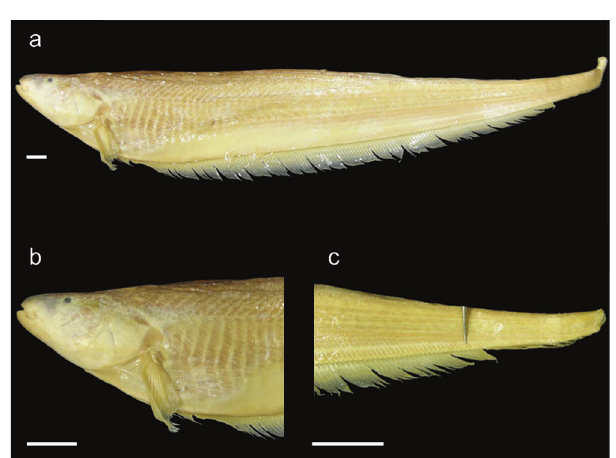
Fig. 20. Sternarchella orthos (USNM 228871). a. Lateral view of the body, b. Lateral view of the head, c. Lateral view of the caudal region showing a single row of intermuscular bones in the caudal peduncle, and the discontinuous caudal peduncle membrane. Scale bars = 1